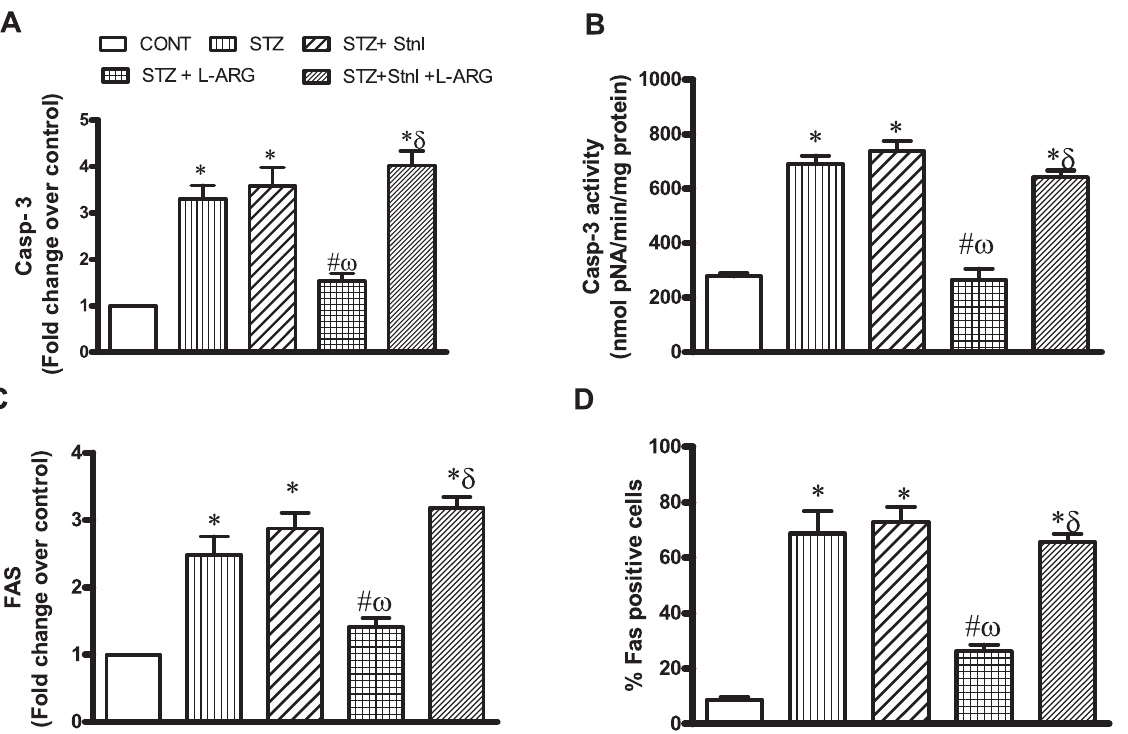
Fig. 5. Effect of STZ alone or in combination with L-ARG or L-ARG + Stnl on caspase-3 (Casp-3) mRNA expression (A) and activity (B) as well as (C) FAS mRNA expression and (D) % FAS positive cells. Data represent the means of six experiments ¡ SEM; *, # , v and d P , 0.05 compared with CONT, STZ, STZ + Stnl and STZ + Stnl + L-ARG, respectively, using one-way ANOVA followed by Tukey’s Multiple Comparison